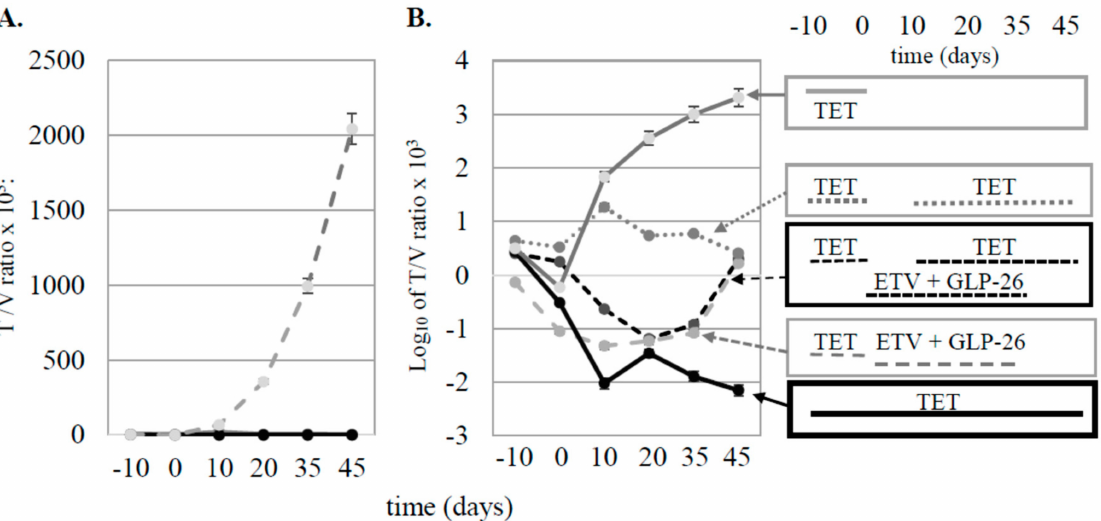
Figure 4. ( A ) Average ratios of T/V for treated (solid black line) and untreated (dashed gray line) groups of mice. ( B ) Data from panel A plotted logarithmically for each group of mice. The treatment protocols for each group of mice are indicated in the rectangles to the right of panel B, and correlate with the groups in Figure 3 as follows: 3A (dashed black line), 3B (dashed gray line), 3C (dotted grey line), 3D (solid black line), and 3E (solid gray